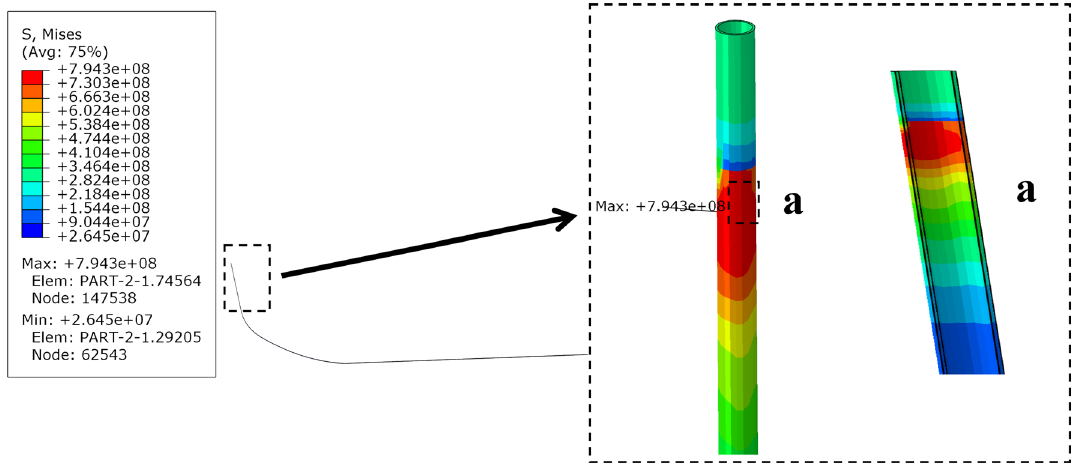
Fig. 19 Cloud map of casing tensile stress distribution under tilting area